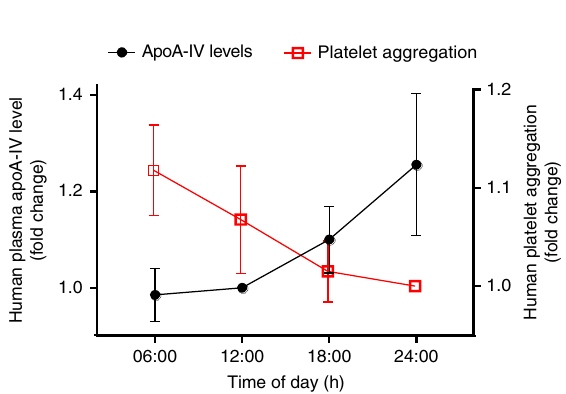
Fig. 9 ApoA-IV attenuates postprandial platelet hyperactivity. a Transgenic mice overexpressing apoA-IV attenuated high fat diet (HFD)-induced transgenic mice (apoA-IV-Tg) were fasted for 12 h and followed by HFD for 3 h. WT mice showed a signi fi cant enhancement in platelet aggregation after acute HFD. ApoA-IV-Tg mice showed a prevention of postprandial platelet hyper-reactivity (top). HFD increased the plasma levels of apoA-IV in apoA-IV-Tg mice (bottom). b De fi ciency of apoA-IV markedly increased postprandial platelet function (top, apoA-IV − / − vs apoA-IV + / + , P < 0.01). HFD increased the plasma levels of apoA-IV in apoA-IV + / + and apoA-IV + / − mice (bottom). HFD high fat diet. n = 12 mice/group from three individual experiments. Unpaired, two-tailed Student ’ s t -test or non- parametric Kruskal – Wallis one-way analysis of variance for multiple paired comparisons. Mean ± SEM. NS not signi fi cant, * P < 0.05, ** P < 0.01 and *** P < 0.001